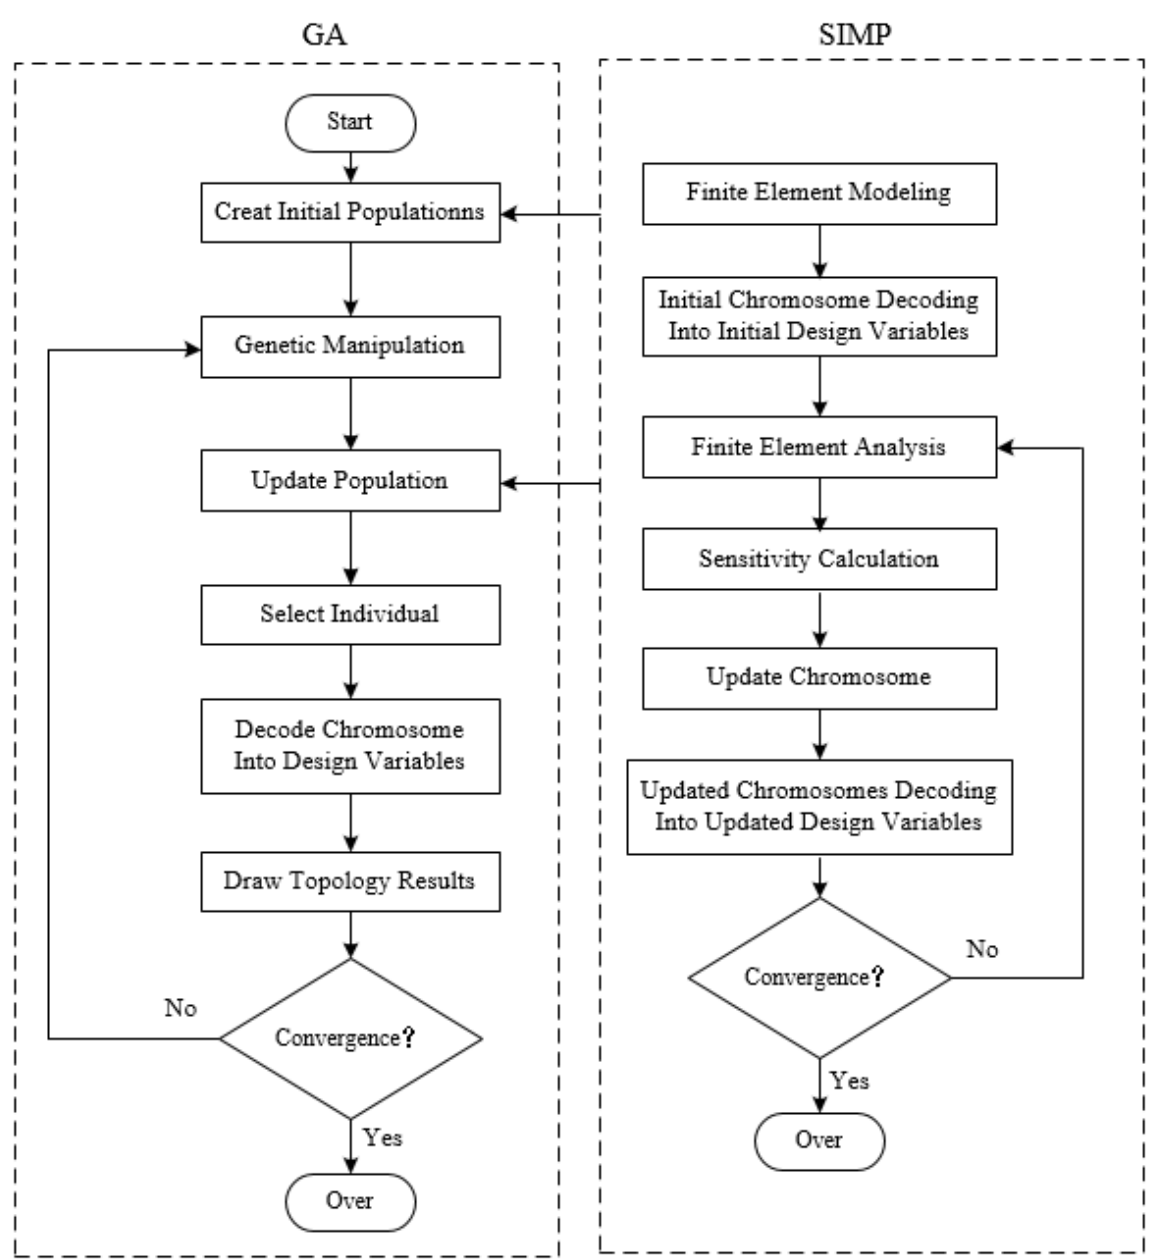
Figure 1. SIMP-GA algorithm flow.